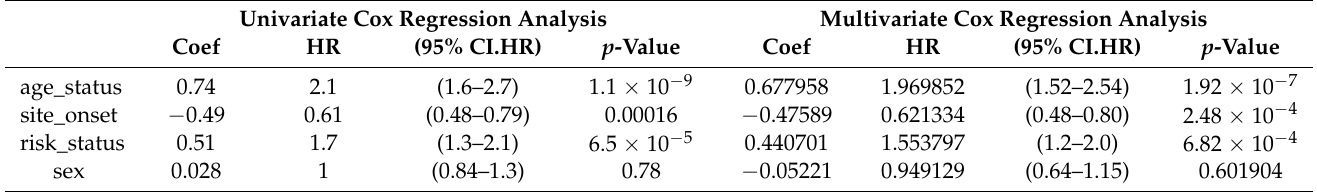
Figure 11. Analysis of prognostic markers in amyotrophic lateral sclerosis (ALS) patients. ( A ) Survival curves of ALS patients in the training dataset. ( B ) Analysis of ALS patients with different survival statuses and survival periods in the training dataset according to risk score. Red indicates the dead ALS patients and blue indicates the surviving ALS patients. The vertical line indicates the median risk score; the left side of the median is low risk, and the right side is high risk. ( C ) Heatmap of the expression of four survival-related genes (MAEA, TPST1, IFNGR2, and ALAS2) in ALS patients in the training dataset. Different colors indicate gene expression levels in different samples. ( D ) Boxplots of the expression of four survival-related genes in ALS patients in the training dataset. ( E ) Survival curves of ALS patients in the validation dataset. ( F ) Analysis of ALS patients with different survival statuses and survival periods according to risk score. Red indicates the dead ALS patients and blue indicates the surviving ALS patients. The vertical line indicates the median risk score; the left side of the median is low risk, and the right side is high risk. ( G ) Heatmap of the expression of four survival-related genes in ALS patients in the validation dataset. Different colors indicate gene expression levels in different samples. ( H ) Boxplots of the expression of four survival-related genes in ALS patients in the validation dataset. Table 2. Univariate Cox regression analysis and multivariate Cox regression analysis on the training